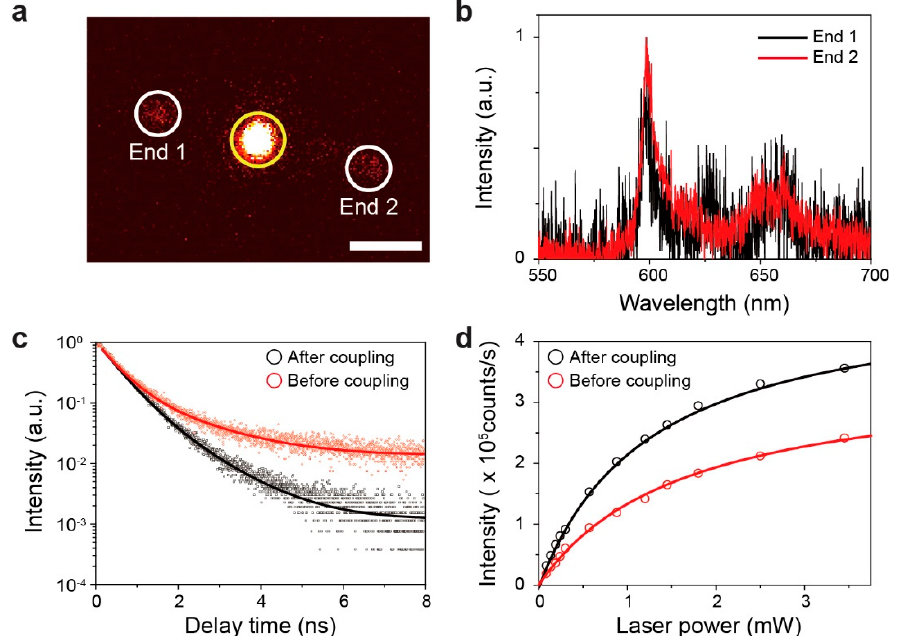
Figure 5. Measurement of Ag nanowire coupled single-photon emission: ( a ) Confocal fluorescence image scan of the single-photon emitter coupled to a Ag nanowire with the excitation laser fixed to the position of the emitter. The yellow and white circles represent the single-photon emitter and two ends of the Ag nanowire, respectively. ( b ) Spectra measured at the ends of the Ag nanowire. These are the same as the spectrum of the h-BN single-photon emitter (Figure 3b). ( c ) Comparison between the time-resolved photoluminescence (TRPL) measurements before and after coupling of the single-photon emitter with a Ag nanowire. The red and black curves were measured before and after coupling, respectively. ( d ) Comparison between the fluorescence saturation curves before and after coupling with a Ag nanowire. The red and black curves were measured before and after coupling, respectively.